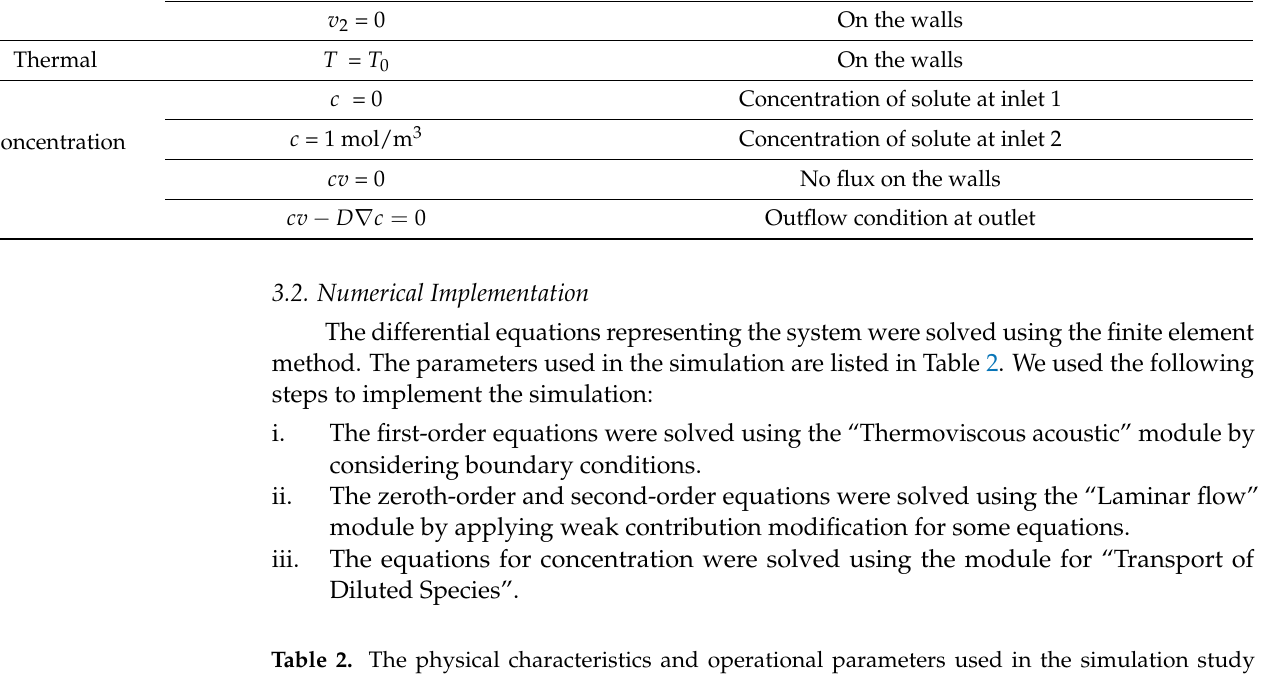
Table 2. The physical characteristics and operational parameters used in the simulation study